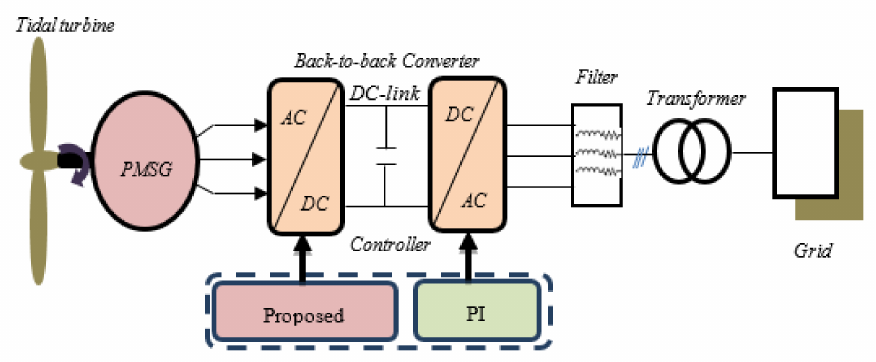
Figure 1. Tidal conversion system under